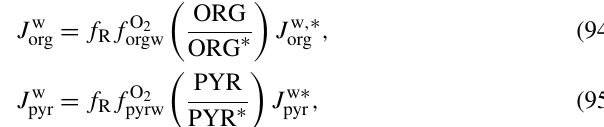
= 0 . 273 × 10 18 mol (Goldblatt et al., 2006). A where K (cid:48) O 2 fraction of organic matter decomposed by methanogenesis, g CH , can be calculated based on Eqs. (89) and (92). Follow- 4 ing this, g O is determined from 1 − g CH 2